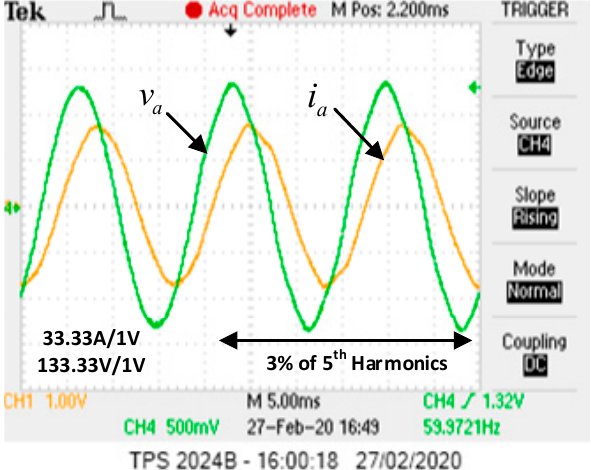
Figure 25. Voltage and current for phase A during inclusion of 3% of 5th harmonic in the grid voltage (120 Vrms and Pref = 10 k Qref = 10 kvar).